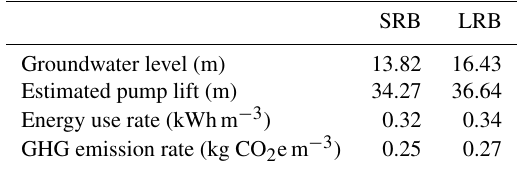
Table 7. Energy use rate and GHG emission rate from irrigation in the SRB and LRB.